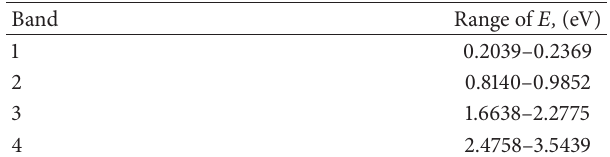
Table 1: The allowed energy ranges or bands as 𝐸 for the proposed composition from Figure 2.